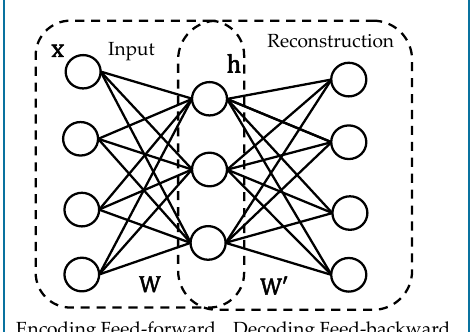
Figure 3. One layer architecture of an AE.